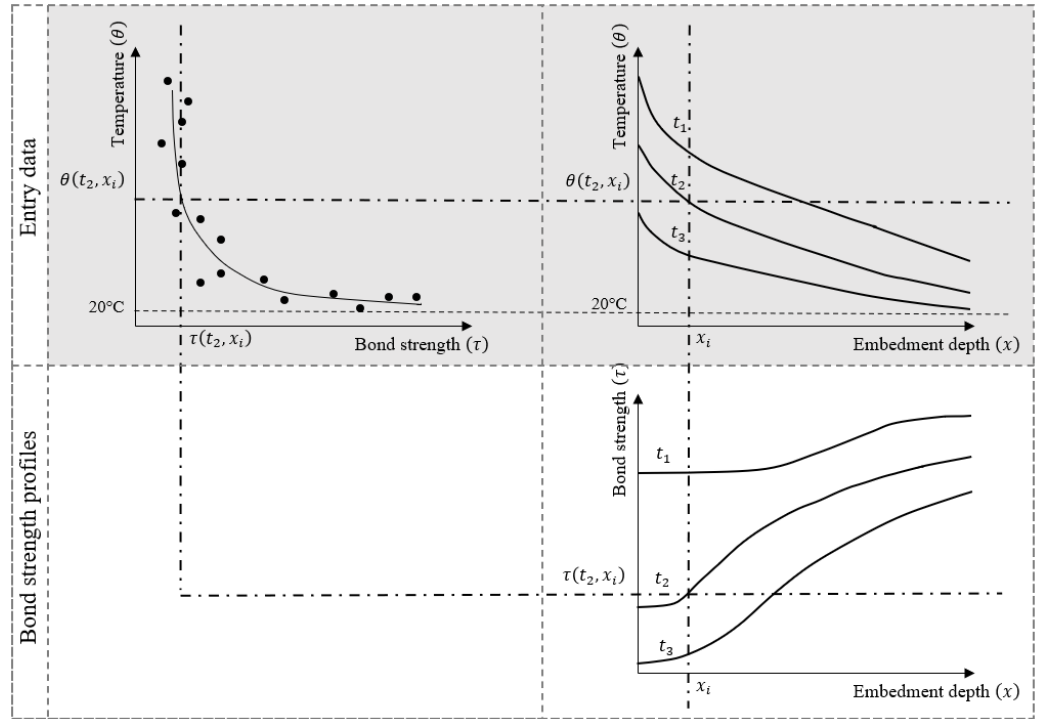
Figure 6. Schematic representation of Pinoteau’s method to obtain resistance profiles of bonded anchors at high tempera- ture [16].